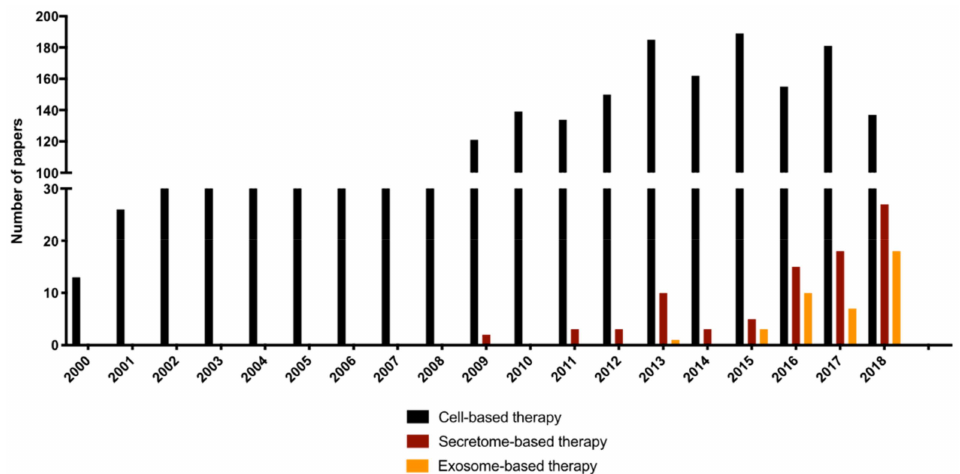
Figure 1. Number of publications per year of cell-, secretome-, or exosome-based therapies on central nervous system (CNS) disorders (Parkinson’s disease (PD), spinal cord injury (SCI), traumatic brain injury (TBI) and ischemic stroke (IS)). An electronic research on PubMed database for literature describing cell-, secretome-, and exosome-based therapies was performed on 18 January 2019 using the following keywords: (cell OR cellular OR stem OR cells) AND (transplantation OR transplant OR “Co-Transplantation” OR Cotransplantation OR engraft OR engraftment OR graft OR grafts) AND (therapy OR therapies OR therapeutics OR therapeutic) NOT Review [Publication Type] AND (“spinal cord injury” or “brain injury” or stroke or parkinson) AND (primates OR mice OR mouse OR rat OR rats OR rodent OR “in vivo” OR “clinical Trials” OR humans) for cell-based therapies and (conditioned medium OR conditioned media OR secretory OR “trophic factors” OR Exosomes OR vesicles OR microvesicles OR vesicular OR “Extracellular vesicles” OR “nanovesicles” OR “exosomal”) AND (therapy OR therapies OR therapeutics OR therapeutic) NOT Review[Publication Type] AND (“spinal cord injury” or “brain injury” or stroke or parkinson) AND (primates OR mice OR mouse OR rat OR rats OR rodent OR “in vivo” OR “clinical Trials” OR humans) for secretome- and exosome-based therapies. The search retrieved 3676 articles for cell-based therapies and 682 articles for secretome- and exosome-based therapies. Data extraction was independently performed by two